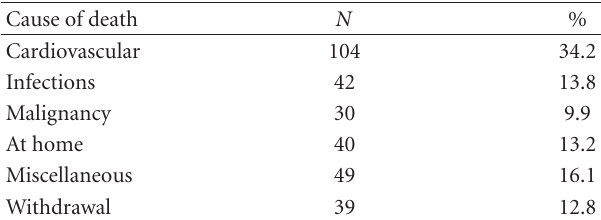
Table 3: Cause of